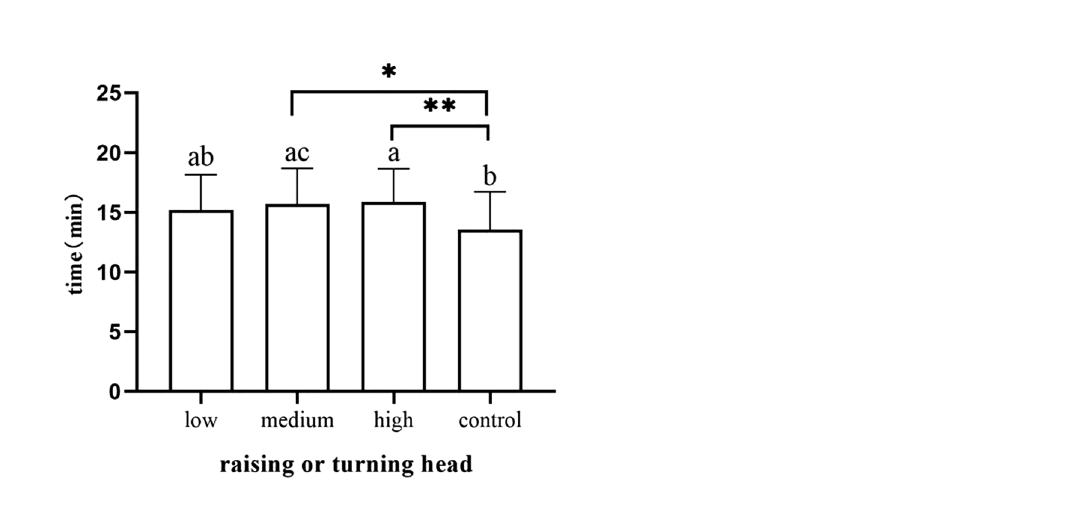
Table 4. Duration time of newborn behavior stage (min). The duration time of the sleep stage was not recorded due to the limitations of the observation time in the delivery room.